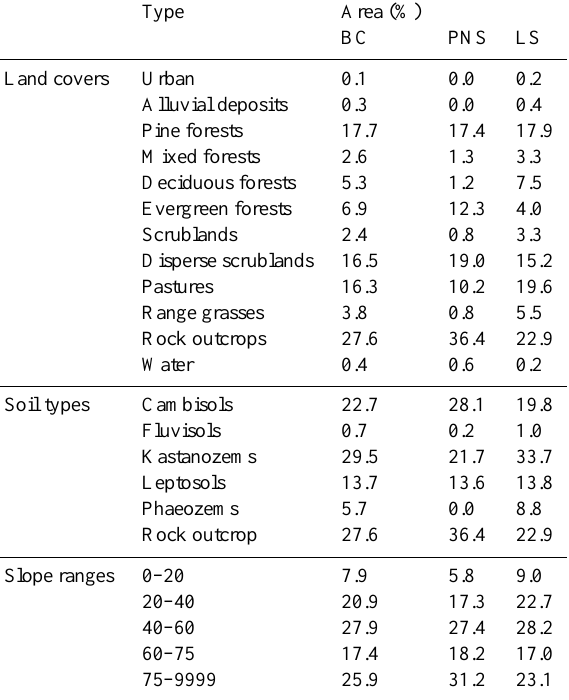
Table 1. Distribution of land covers, soil types and slope ranges (%) in SWAT input data of the Benasque catchment (BC) and of sub- catchments (PNS: Paso Nuevo; and LS: Linsoles